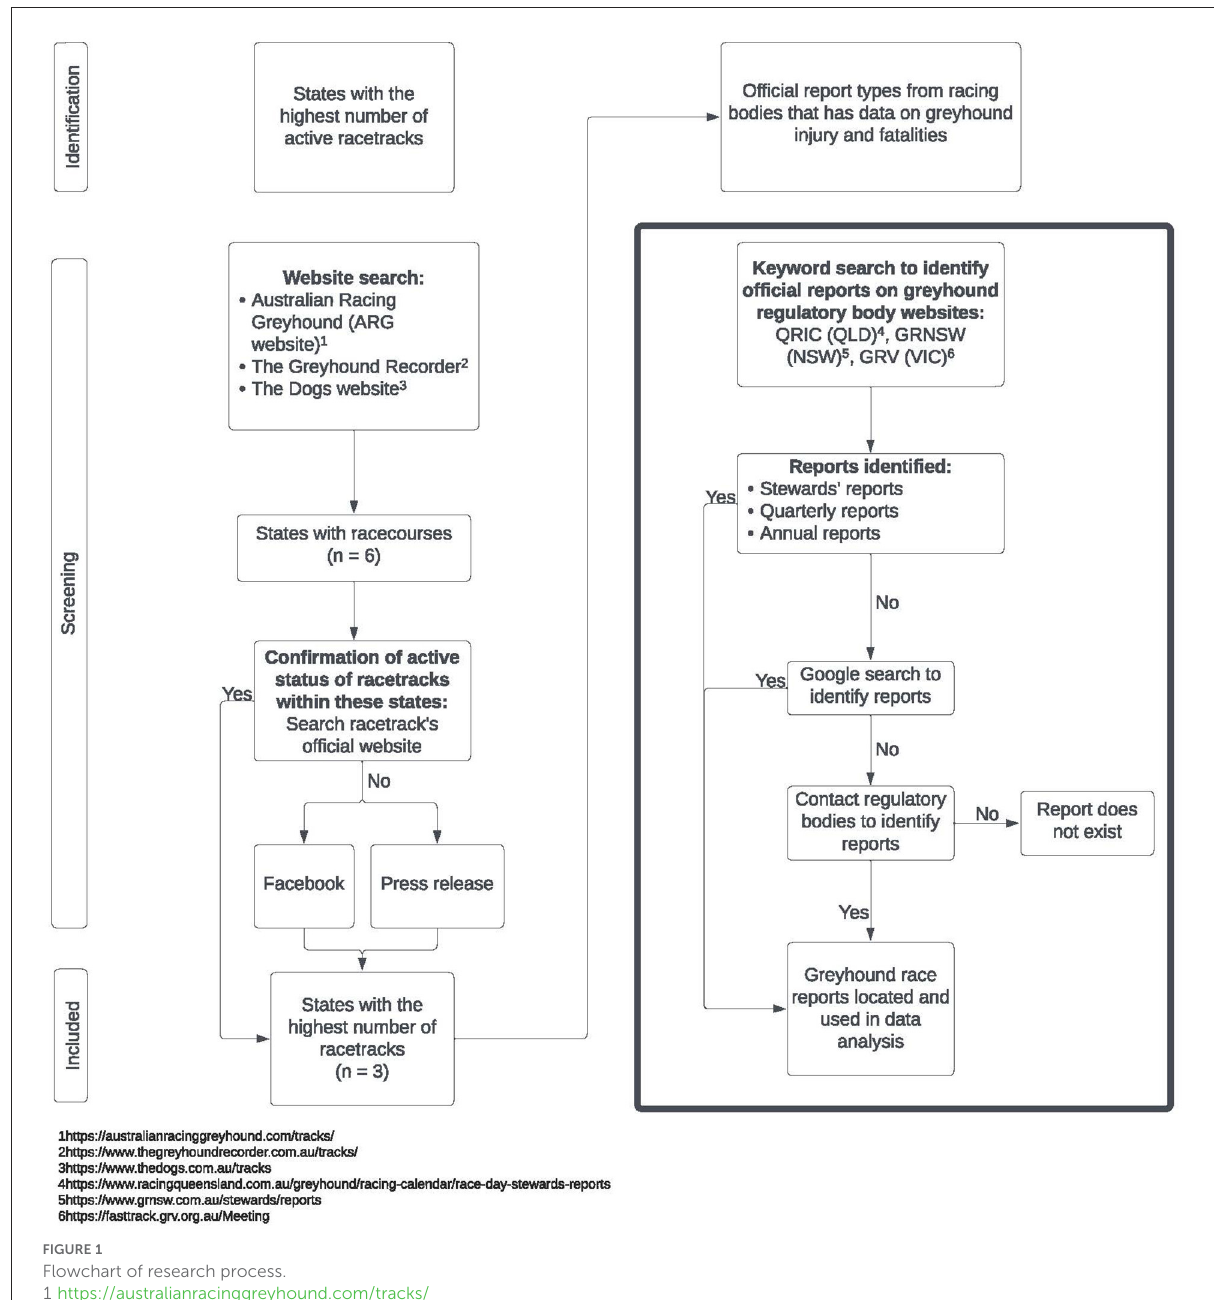
FIGURE1 Flowchart of research